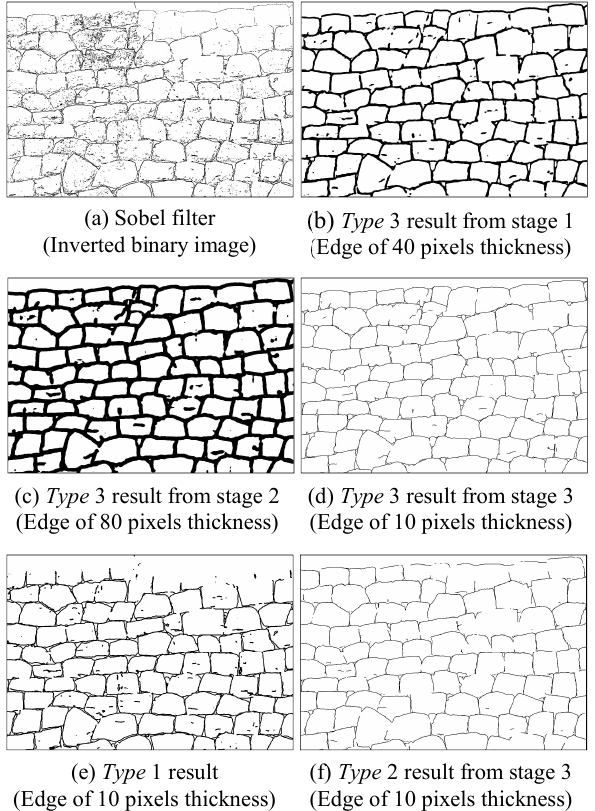
Figure 6. Edge detection results by proposed method